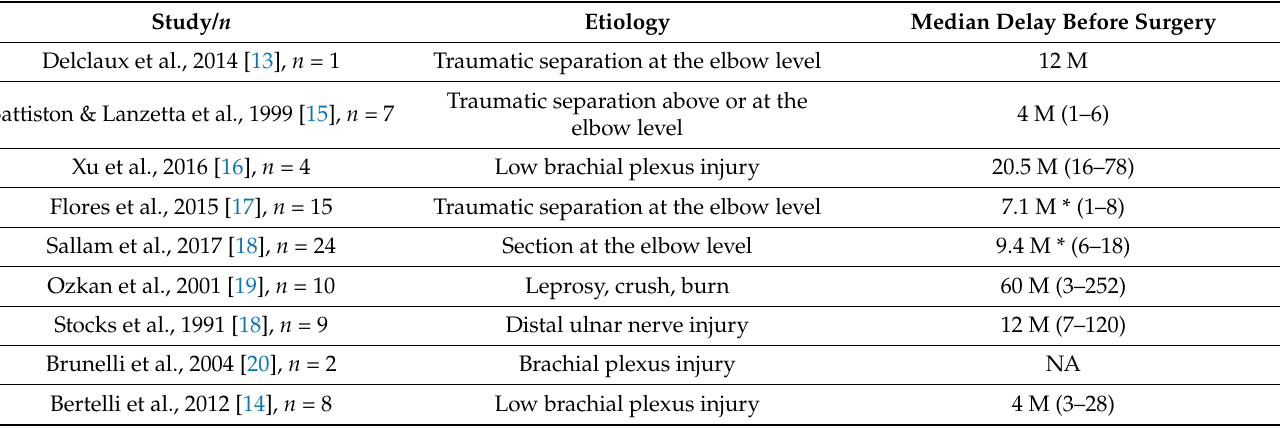
Table 2. Characteristics of the studies included assessing sensory neurotization of the ulnar